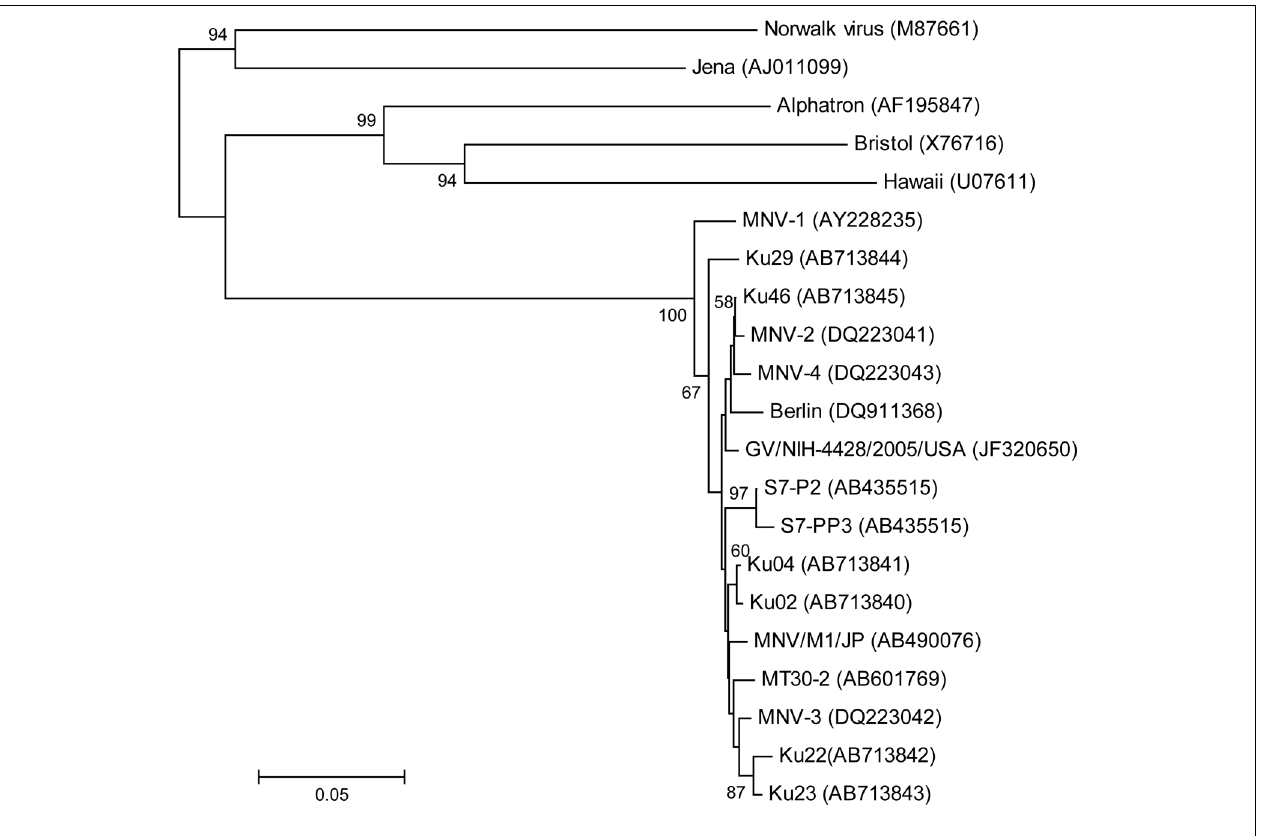
FIGURE 3 | Phylogenetic analysis of the partial capsid gene of norovirus (approximately 350 nucleotides). Phylogenetic relationships were inferred using the neighbor joining method, with the evolutionary distances computed using the p-distance model.The statistical support for tree nodes was evaluated by bootstrap analysis (1,000 replicates). Bootstrap values ( > 50%) are indicated at branch nodes. Scale bar